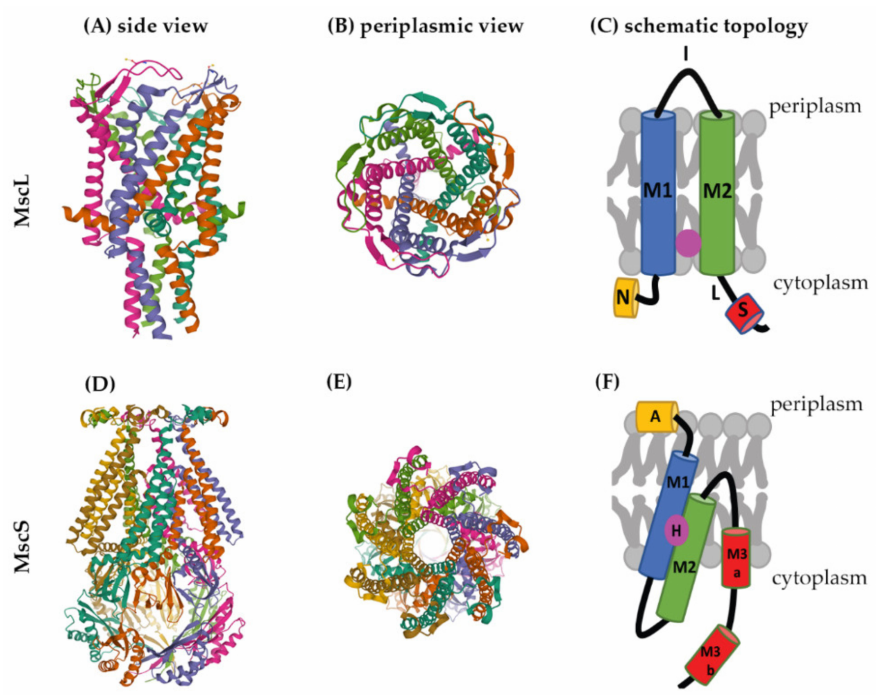
Figure 2. Structures of MscL and MscS. The structure of Mt-MscL ( A – C ) was derived from X-ray crystallography (PDB: 2OAR) [33]. ( A ) Side view, ( B ) periplasmic view, ( C ) schematic topological depiction of an MscL monomer. The structure of Ec-MscS ( D – F ) was derived from cryo-electron microscopy in lipid nanodiscs (PDB: 6PWP) [34]. ( D ) Side view, ( E ) periplasmic view, ( F ) schematic topological depictions of an MscS monomer. Schematic topological depictions of MscL and MscS were adapted from Pivetti et al. and Reddy et al. [1,34], respectively (relative sizes of domains not to scale). A: Anchor, N: N-terminal α -helix, M1, M2, M3a, and M3b: transmembrane